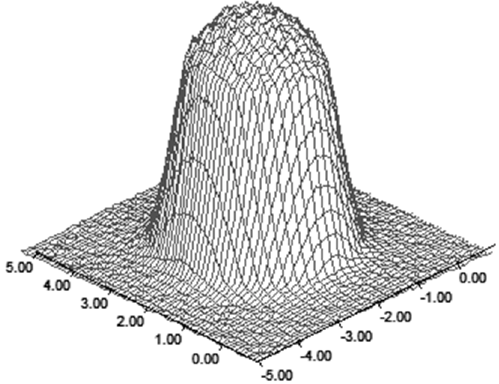
Figure A1. Measured laser intensity profile using a Primes FocusMonitor FM 120. Table A1. Overview of the varied process parameters and the variation range.